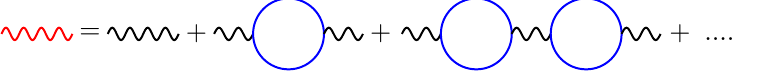
Figure 1 . E(cid:11)ective photon propagator (red wavy line). The black wavy line stands for tree level photon propagator.